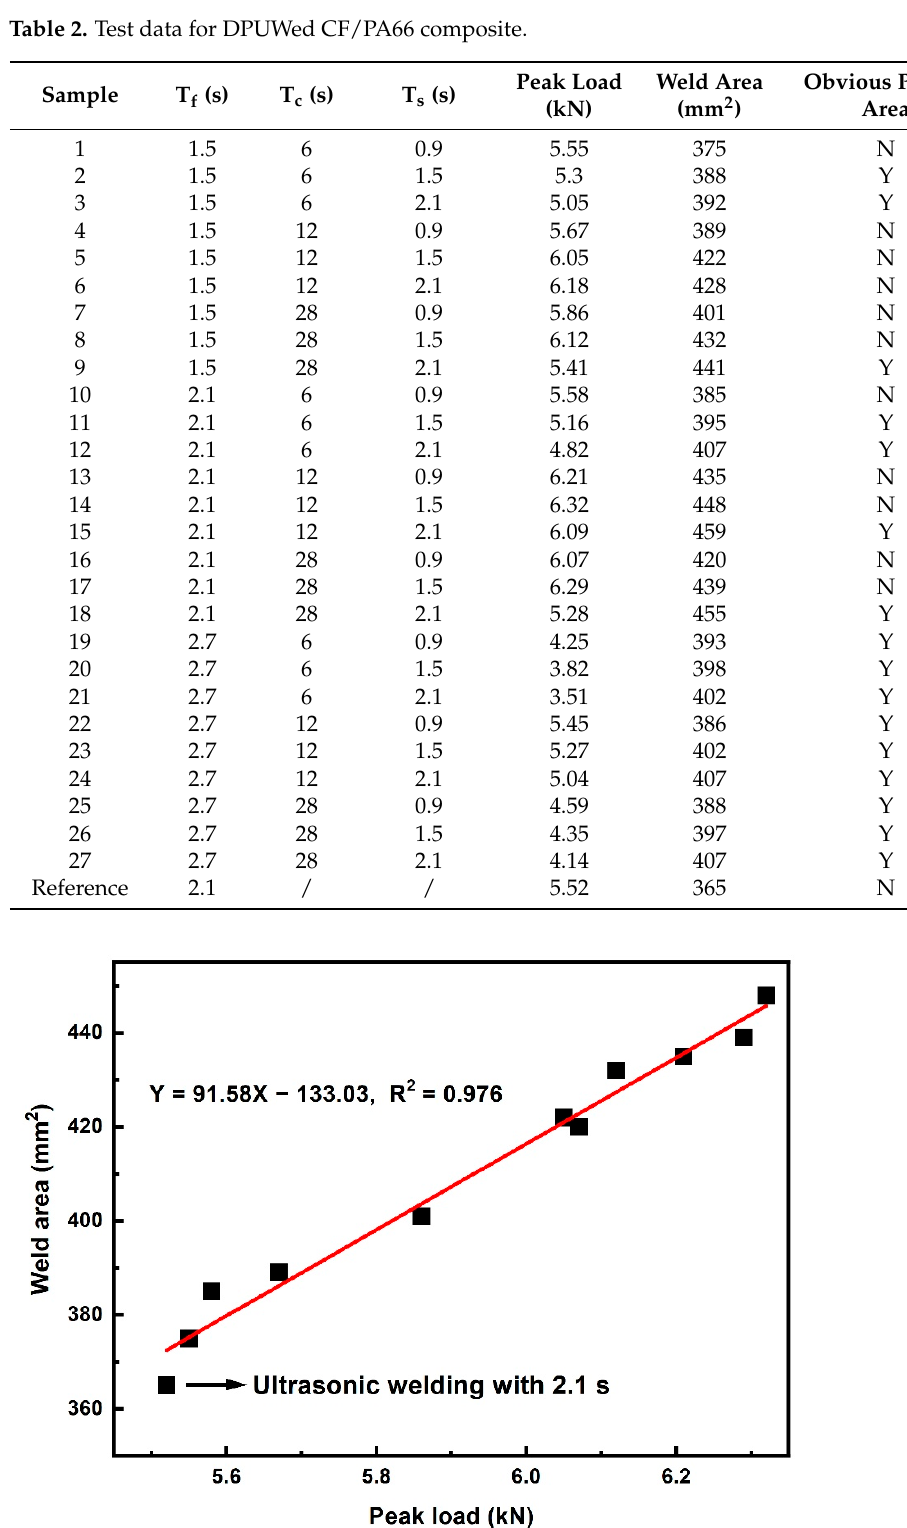
Figure 10. Relation between peak load and weld area for DPUWed joints.